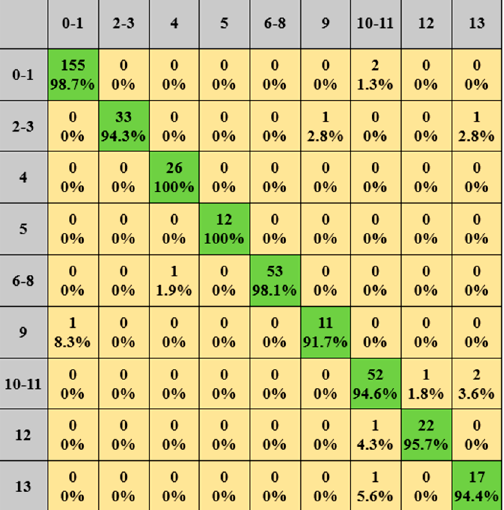
Figure 10. Identi fi cation results of multi-state load and similar load. ( Green means true, yellow means false ) From the results, it can be seen that the correct identi fi cation rate of each type of load is above 91.7%, among which the light 1 and light 2 reach 100%, with an average correct rate of 96.4%. Similarly, for the load socket, washer dryer, and electric furnace, the correct identi fi cation rate is more than 94.4%, and the average correct rate is 94.9%. The correct recognition rate of multi-state devices such as the fridge, light, microwave, and socket is above 92.3%, and the average correct rate reaches 96.5%. Table 2 is evaluated by P, R, F1, and A. As can be seen from Table 2, most of the P, R, F1, and A of various types of loads were kept at 0.85 and above, and light 3 reached 1, with the average values of 0.95, 0.96, 0.96, and 0.99, respectively. Table 2. Evaluation indexes of confusion matrix. P